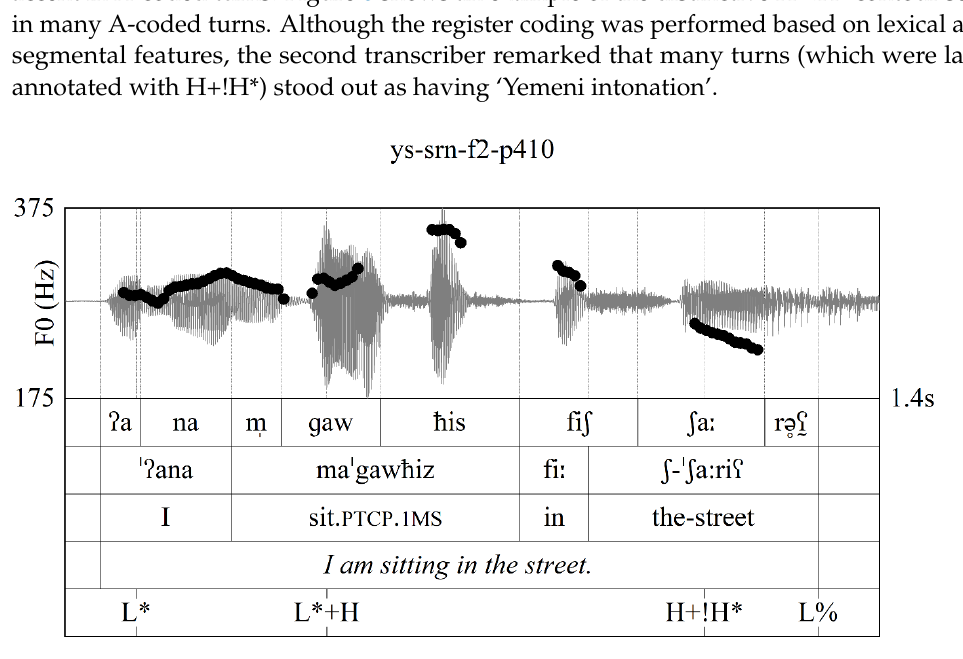
Figure 6. An A-coded turn realized with an H+!H* L% nuclear contour.